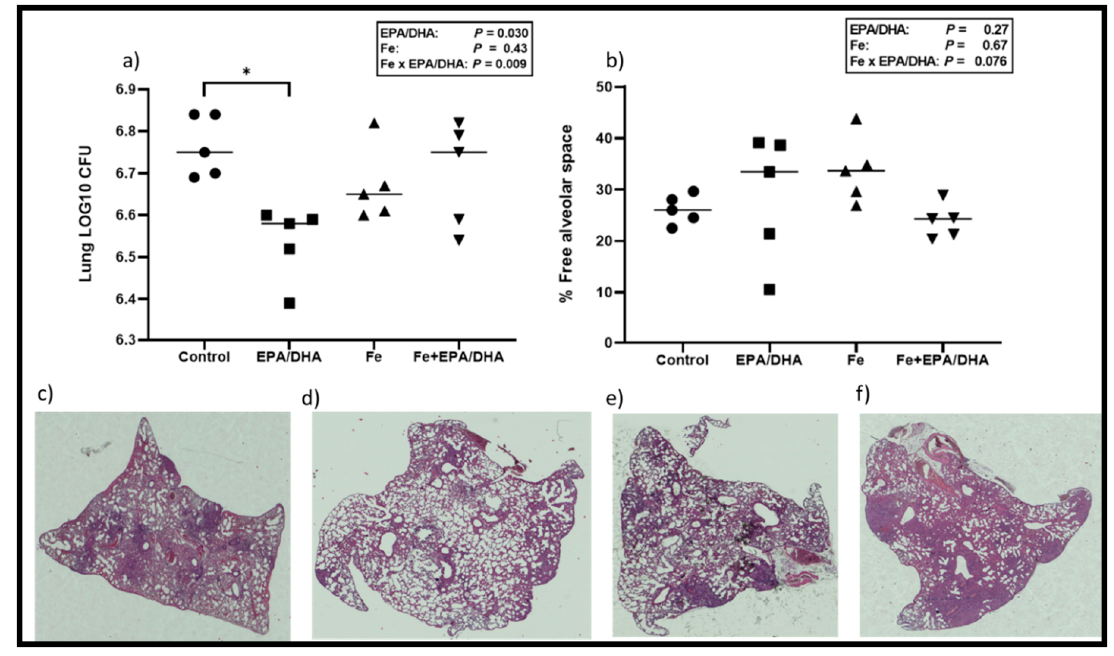
Figure 3. ( a ) Mean lung bacterial load, ( b ) free alveolar space (%), and representative hematoxylin-eosin staining of lungs for ( c ) control, ( d ) EPA/DHA, ( e ) Fe, ( f ) Fe+EPA/DHA groups after providing Mtb -infected mice with control, EPA/DHA, Fe, or Fe+EPA/DHA diets for three weeks. The values represent mean ± SEM. Results repeated in two experiments, data shown for one experiment ( n = 5 per group). Two-way ANOVA was used to test effects of EPA/DHA (control & Fe vs. EPA/DHA & Fe+EPA/DHA), Fe (control & EPA/DHA vs. Fe & Fe+EPA/DHA), and Fe × EPA/DHA interactions.